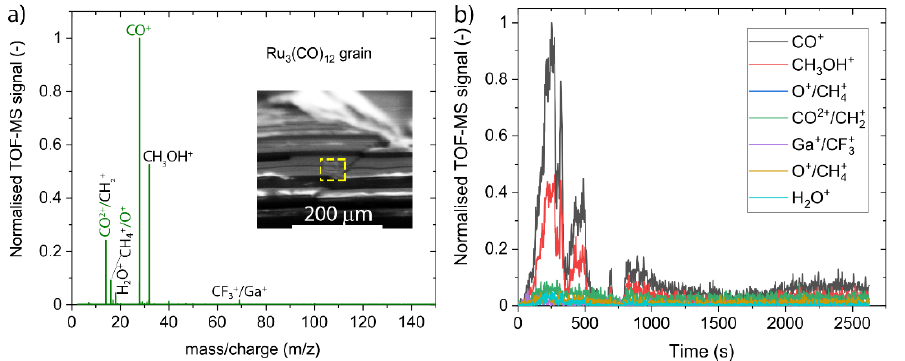
Figure 3. FEBiMS spectra of Ru 3 (CO) 12 at 10 keV and 30 nA electron irradiation. ( a ) Accumulated spectrum over 2600 s. The inset shows a 55 ◦ tilt SEM picture of a part of the Ru 3 (CO) 12 grain with the visible rectangular-shaped hole created during irradiation with electrons. ( b ) Time evolution of fragment peaks seen in ( a